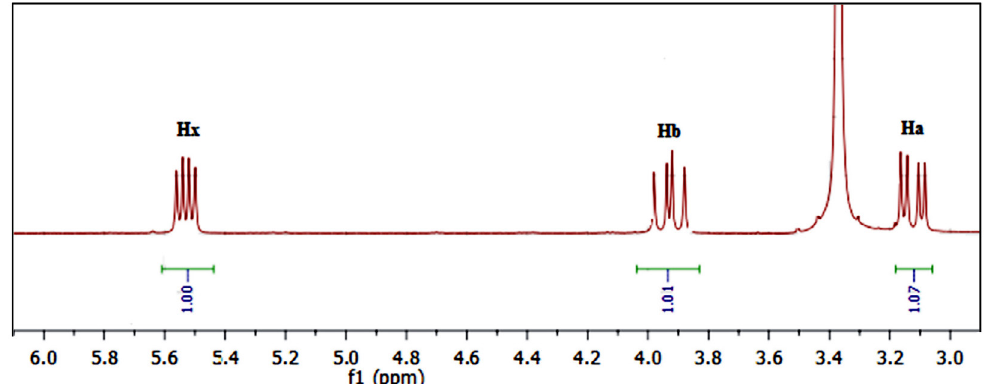
Figure 3. Esxample 1 H NMR spectrum of pyrazoline protons (Ha, Hb and